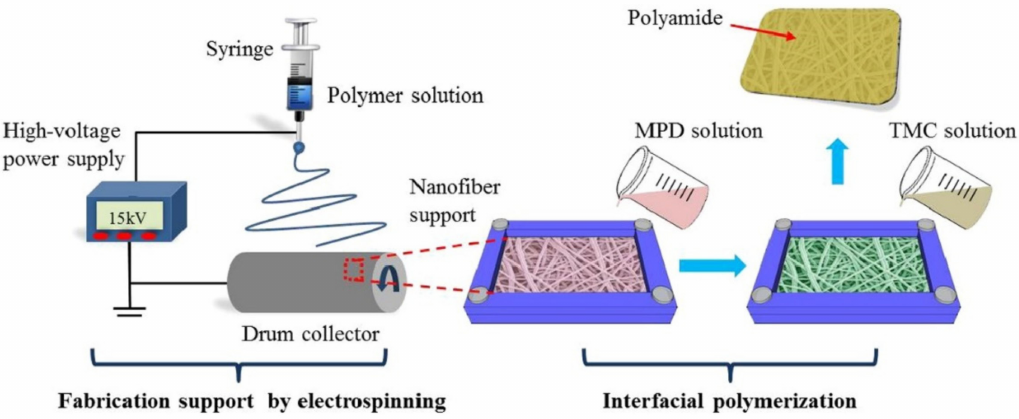
Figure 13. Electrospinning process used to fabricate multilayer water filters [38].